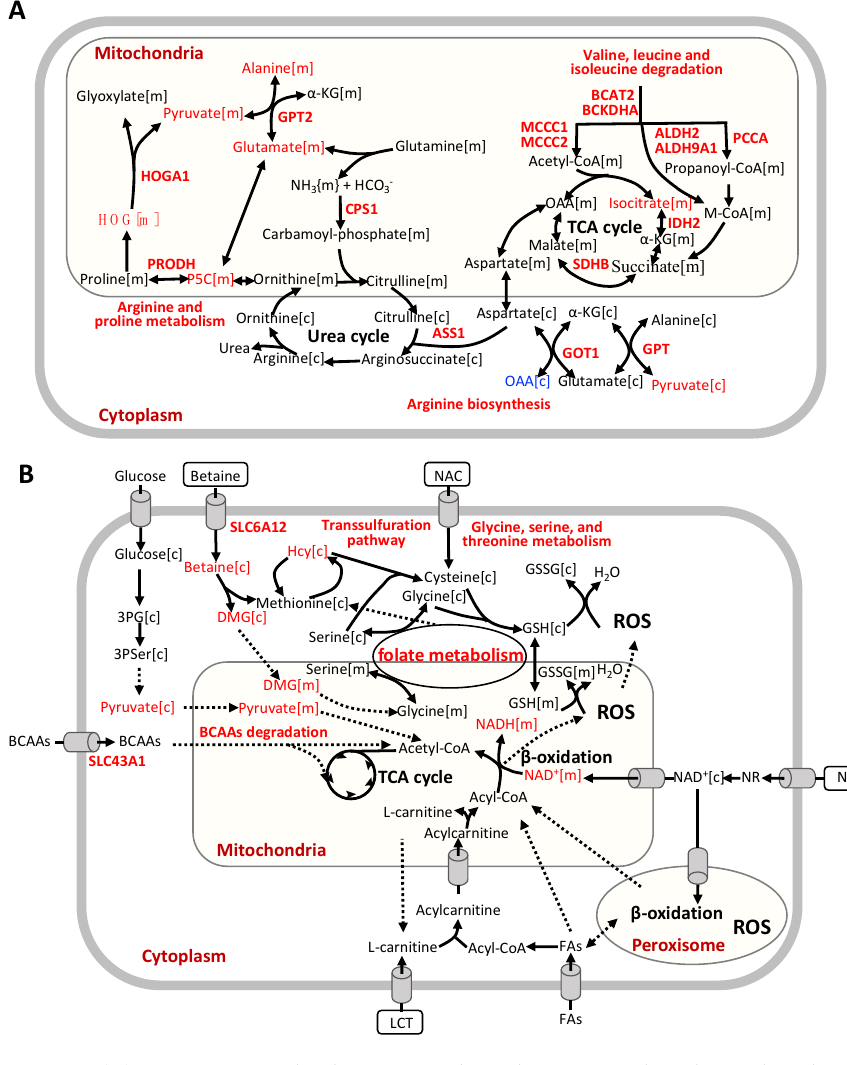
Figure 6. ( A ) Reactions involved in BCAA degradation, tricarboxylic acid cycle, and urea cy- cle. ( B ) Global effect of CMA supplementation. Abbreviations: BCAAs, branched-chain